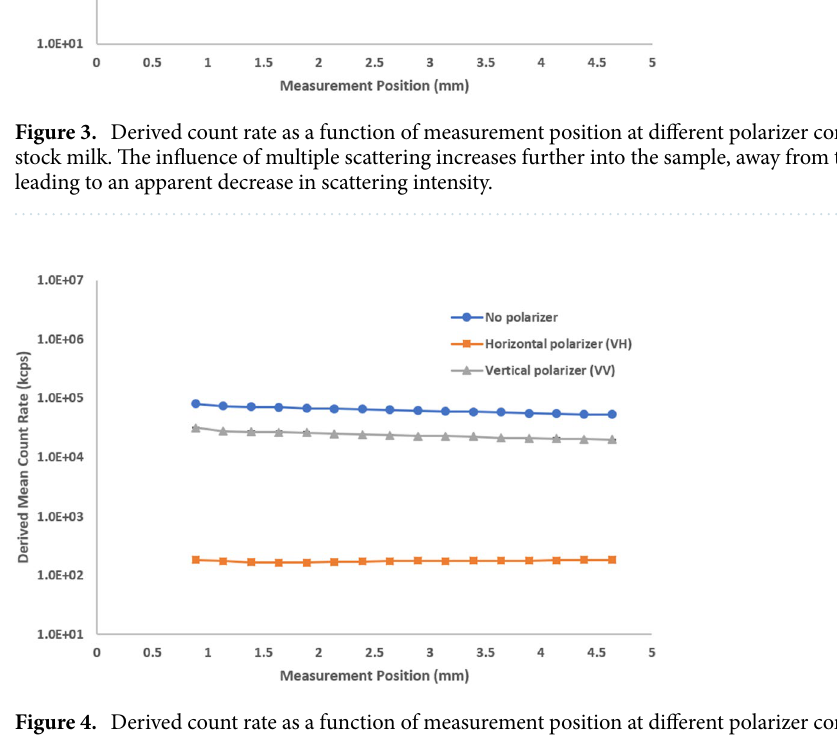
Figure 4. Derived count rate as a function of measurement position at different polarizer configurations for 1000-fold diluted milk. The dilution exhibits more single scattering with minimal change in count rate over position and no cross-polarized signal (no signal in the horizontal